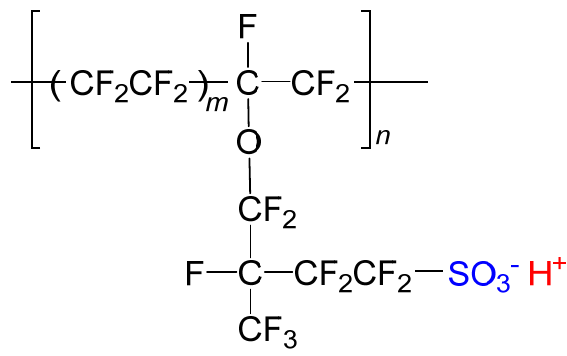
Figure 1. Structural formula of Nafion (acid form).